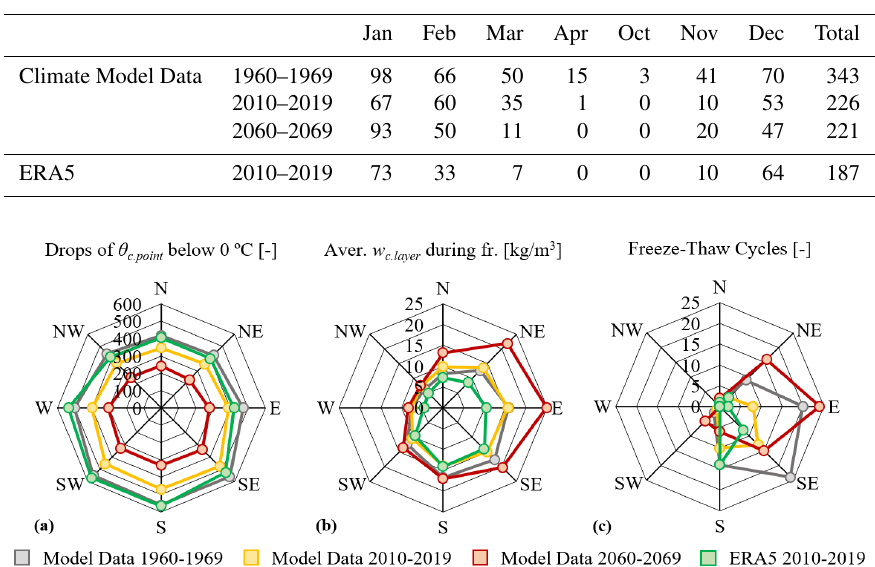
Figure 10. (a) Number of events during which the temperature at the control point 2.5mm in depth from the outer side of the simulated wall drops below 0 ◦ C. (b) Average moisture content at the 5mm layer at the outer side of the wall during the periods that the θ controlpoint is below 0 ◦ C. (c) Total number of freeze-thaw cycles according to the material response-based